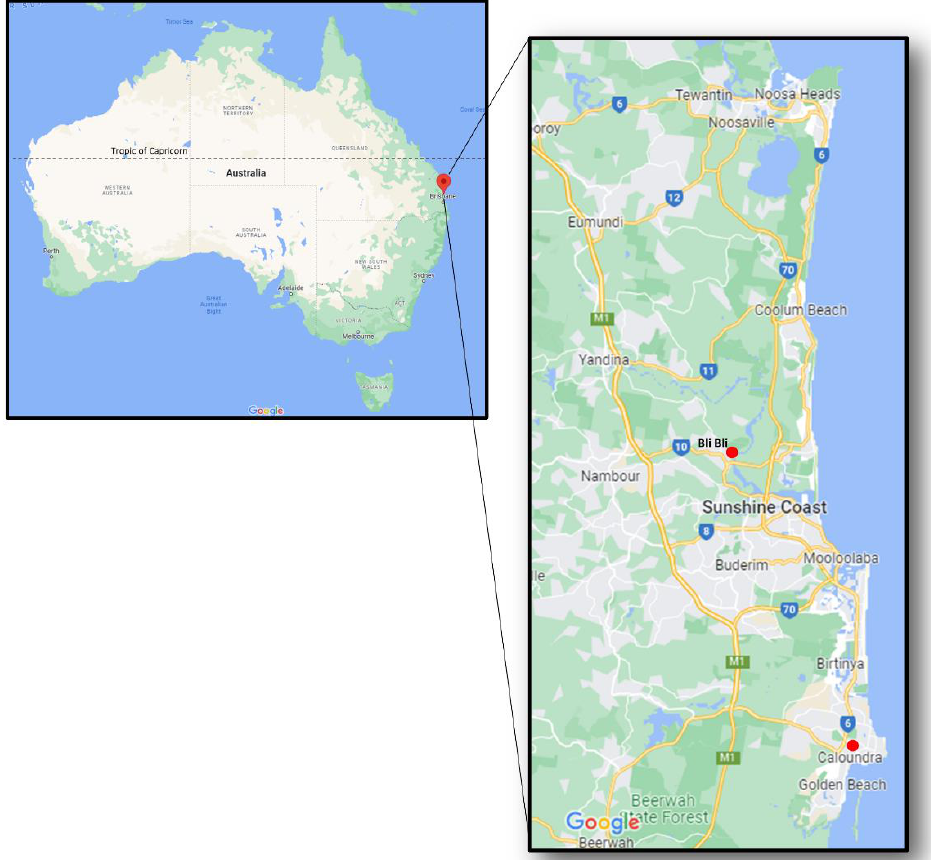
Figure 2. Location of Sunshine Coast and ACF case study sites (Image Source: Google Maps).